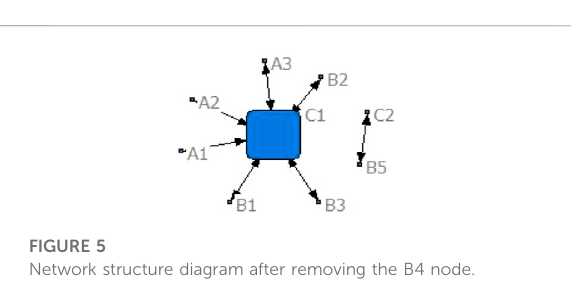
FIGURE 5 Network structure diagram after removing the B4